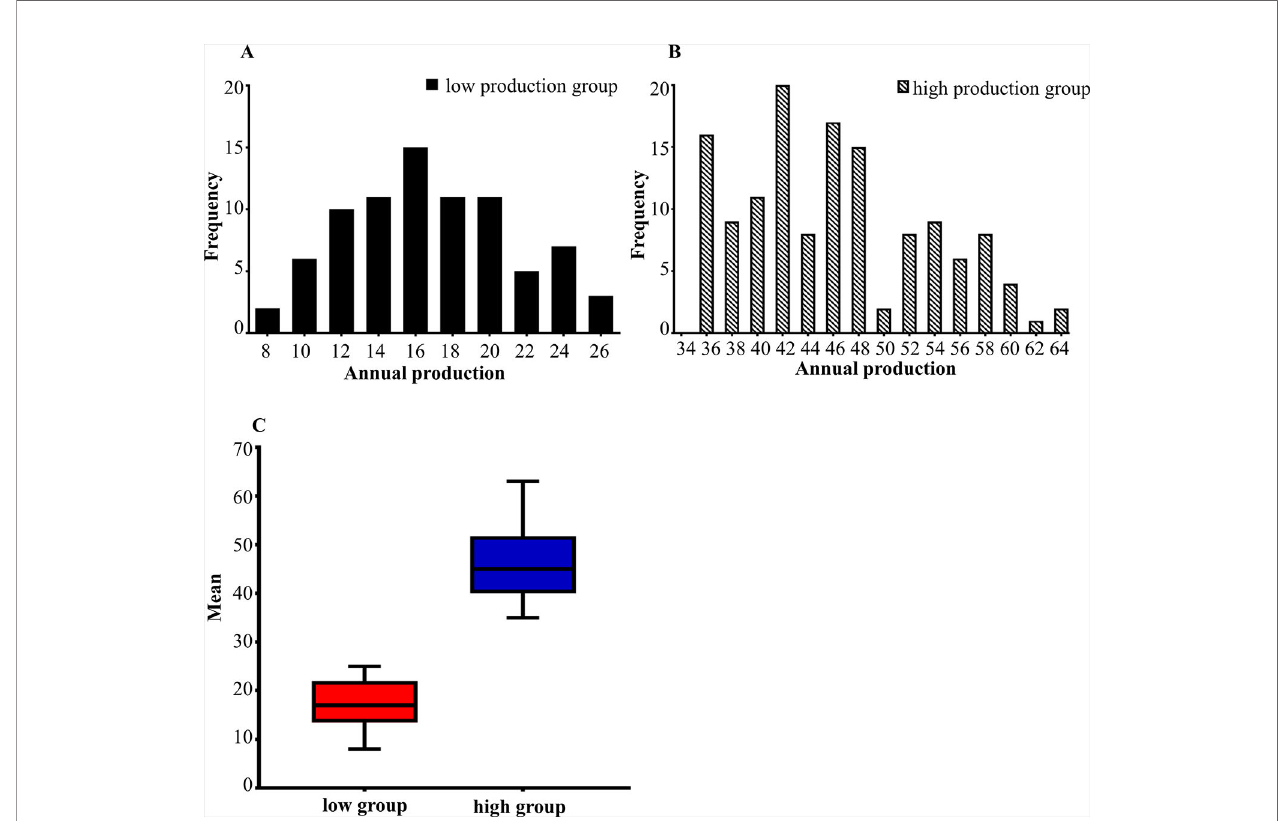
FIGURE 1 | (A, B) The distribution of egg production in two groups. The horizontal axis shows the annual egg production and the vertical axis shows the frequency. (A) is the distribution of low egg production group. (B) is the distribution of high egg production group. (C) is the boxplot of the average between the high and low egg production